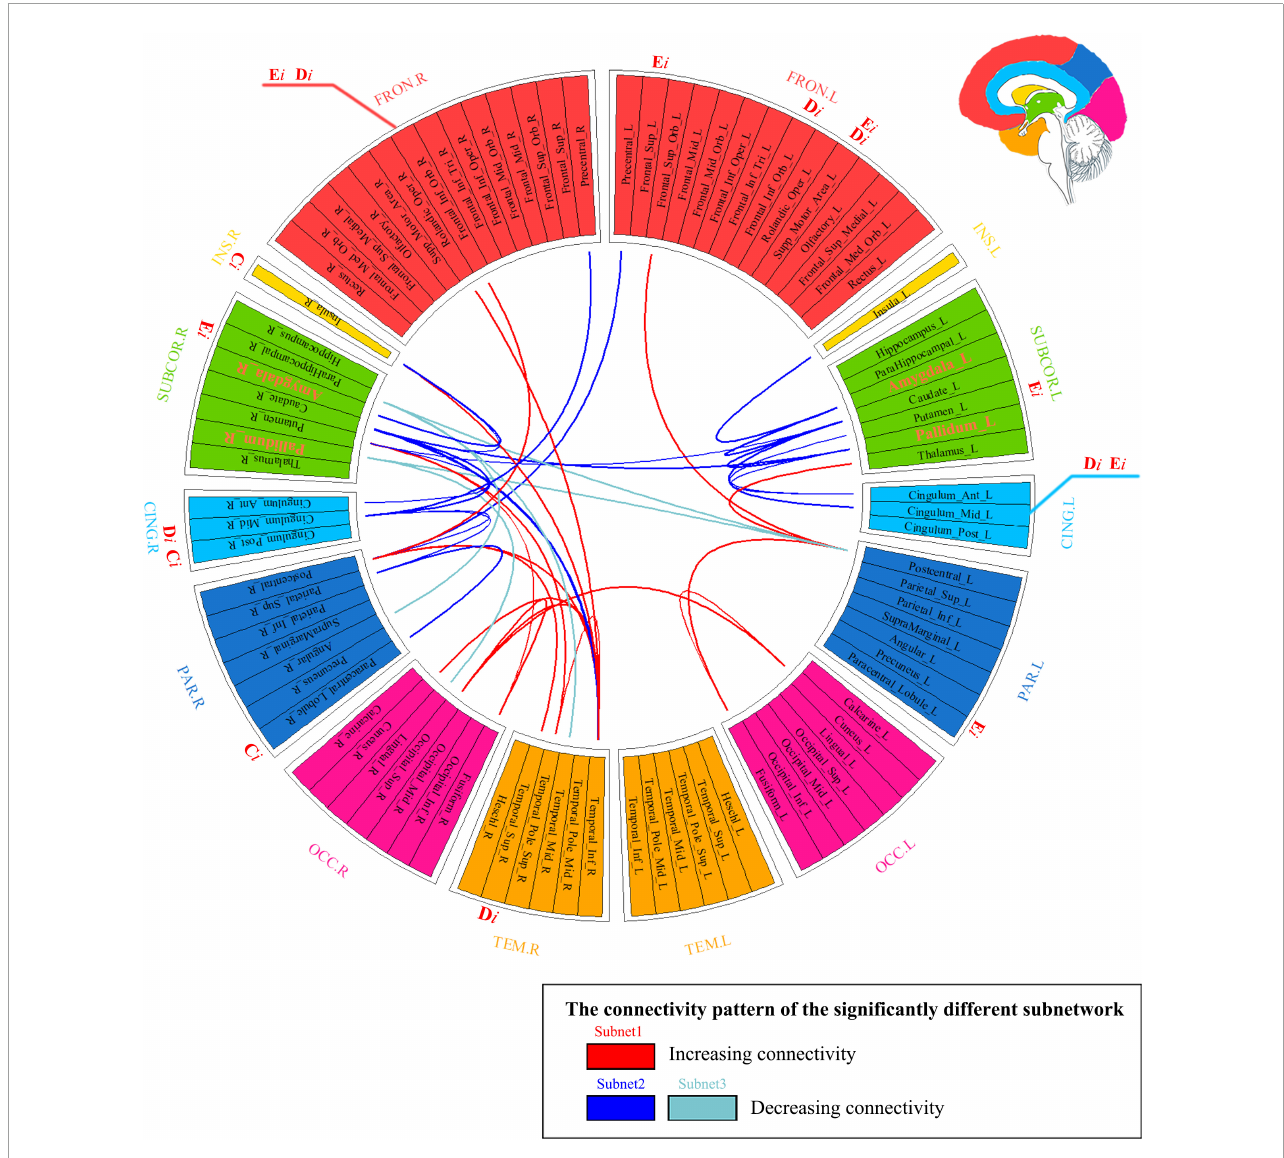
FIGURE5 Summarizing the results of network analysis. It represented three subnetwork results (i.e., subnetworks 1–3) whose connections are marked with different colors in the connectogram. If a nodal measure showed the existence of a significant between-group difference, the location of the outer ring of the circle corresponding to this node was labeled as the nodal measure’s name (namely D i , E i , and C i ). If the nodal measure’s name was colored with red, it meant that the corresponding value increased. Hubs’ name was marked with orange color and with a larger font size in the ring. FRON, frontal cortex; INS, insula; SUBCOR, subcortical region; CING, cingulum; PAR, parietal cortex; OCC, occipital cortex; TEM, temporal cortex; L, left hemisphere; R, right